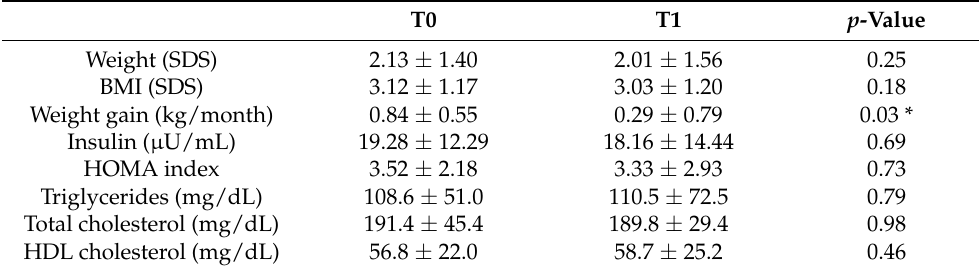
Figure 1. Evaluation of equivalent age according to Vineland Adaptive Behavior Scales.